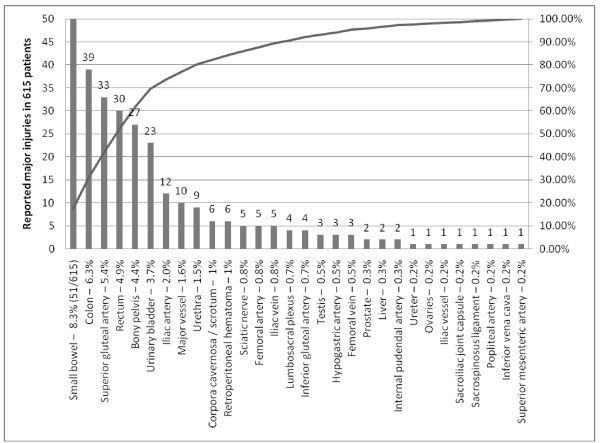
Types of major injury in 615 patients with penetrating trauma to the buttock.